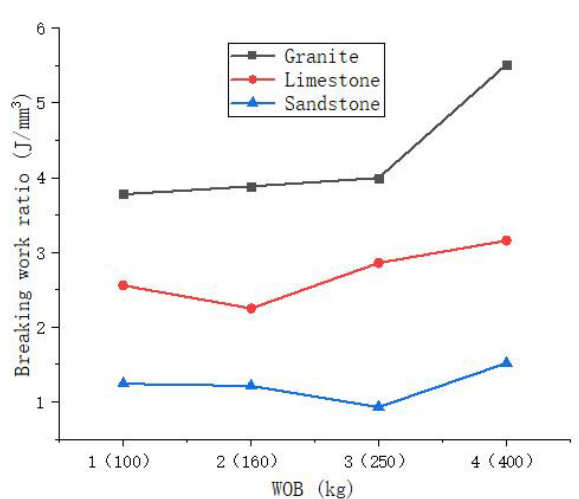
Figure 10. The relation curve between breaking work ratio and ro- tary speed.